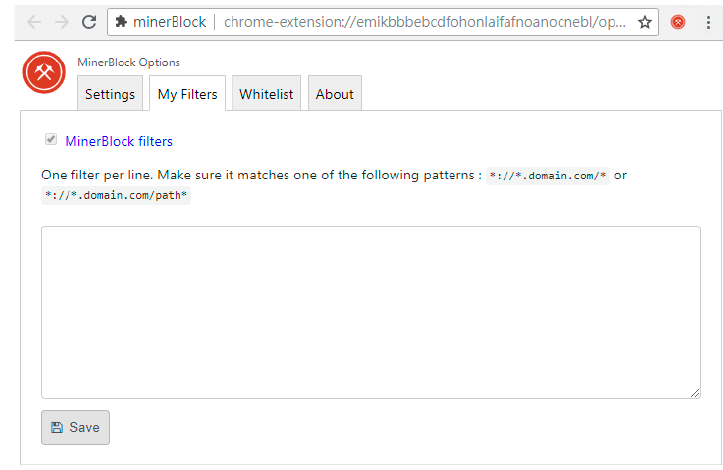
Figure 5. MinerBlock filter settings.